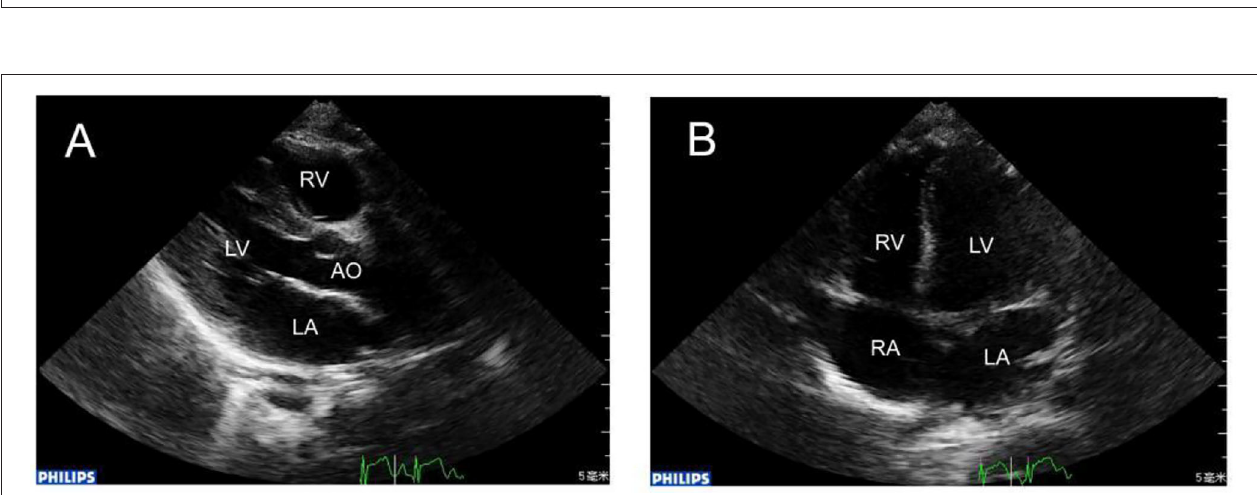
FIGURE 2 | (A) 1 year later, repeat echocardiography showing that the RCA was in normal size. (B) The apex four-chamber view showed that in the same position the huge thrombus disappeared.